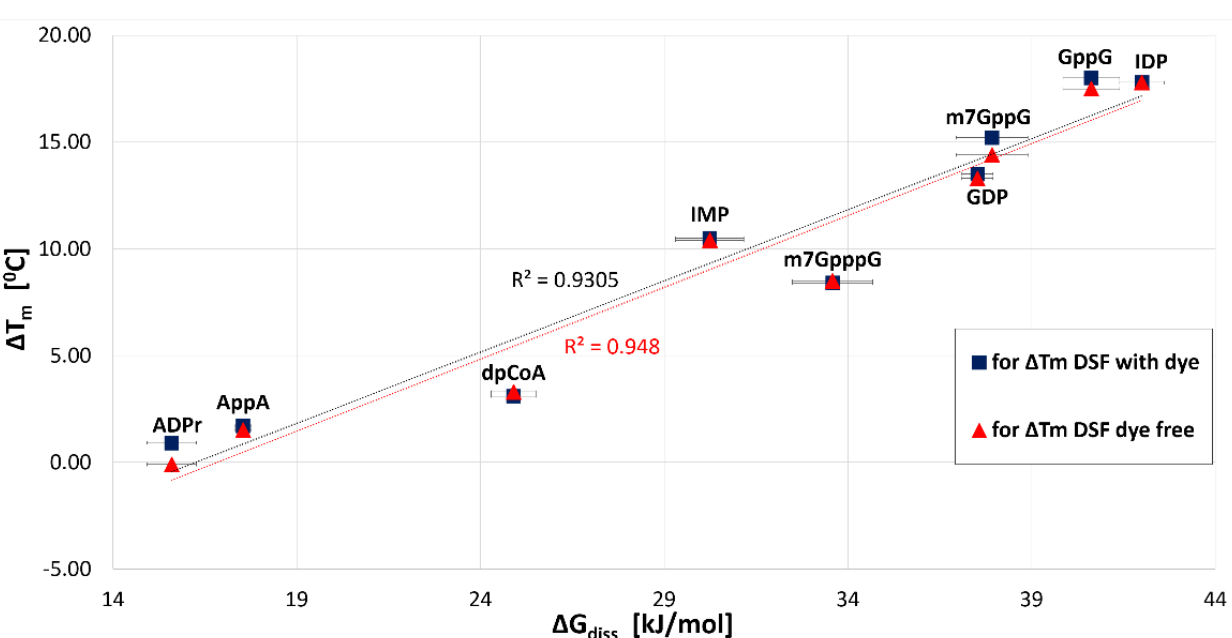
Figure 4. Comparison of the free energy associated with the dissociation of the complex ( ΔG diss ) calculated for stronger binding site (with K d1 obtained from MST) with ΔT m obtained from dye-free and DSF with dye measurements for tested hNudt16E76Q-ligand pairs.